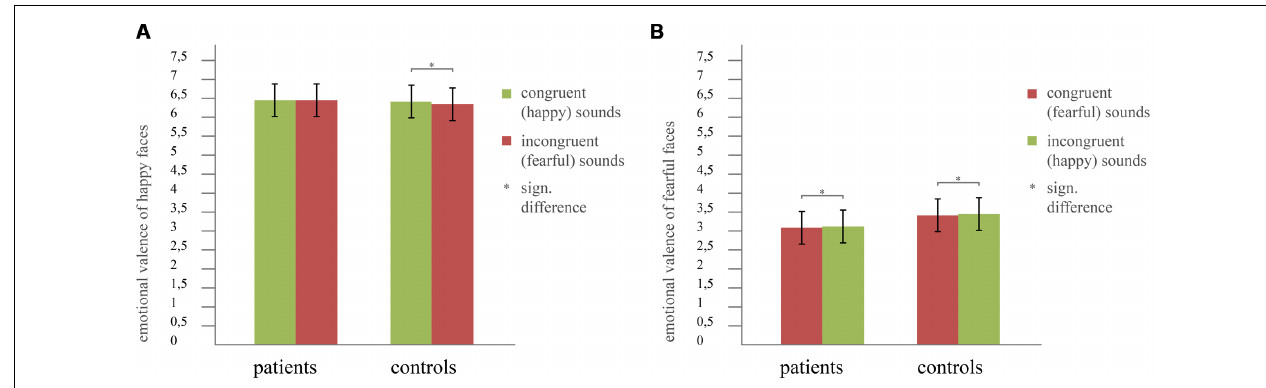
FIGURE 3 | Incongruence effect for (A) happy faces, revealing a significant interaction congruence × group and (B) fearful faces showing no group differences. Error bars indicate the SD of mean. Asterisks indicate significant differences revealed by post hoc tests at p < 0.05, Bonferroni-corrected for multiple